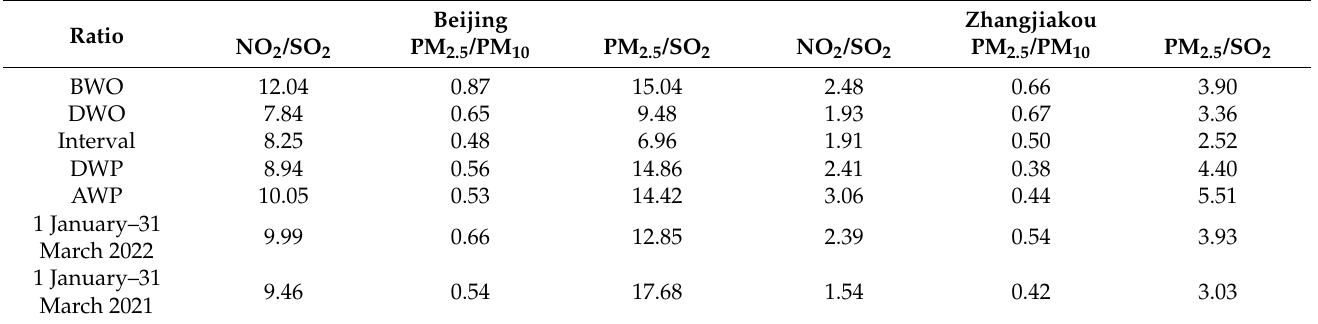
Table 4. Correlation analysis between air pollutants and meteorological factors in Beijing and